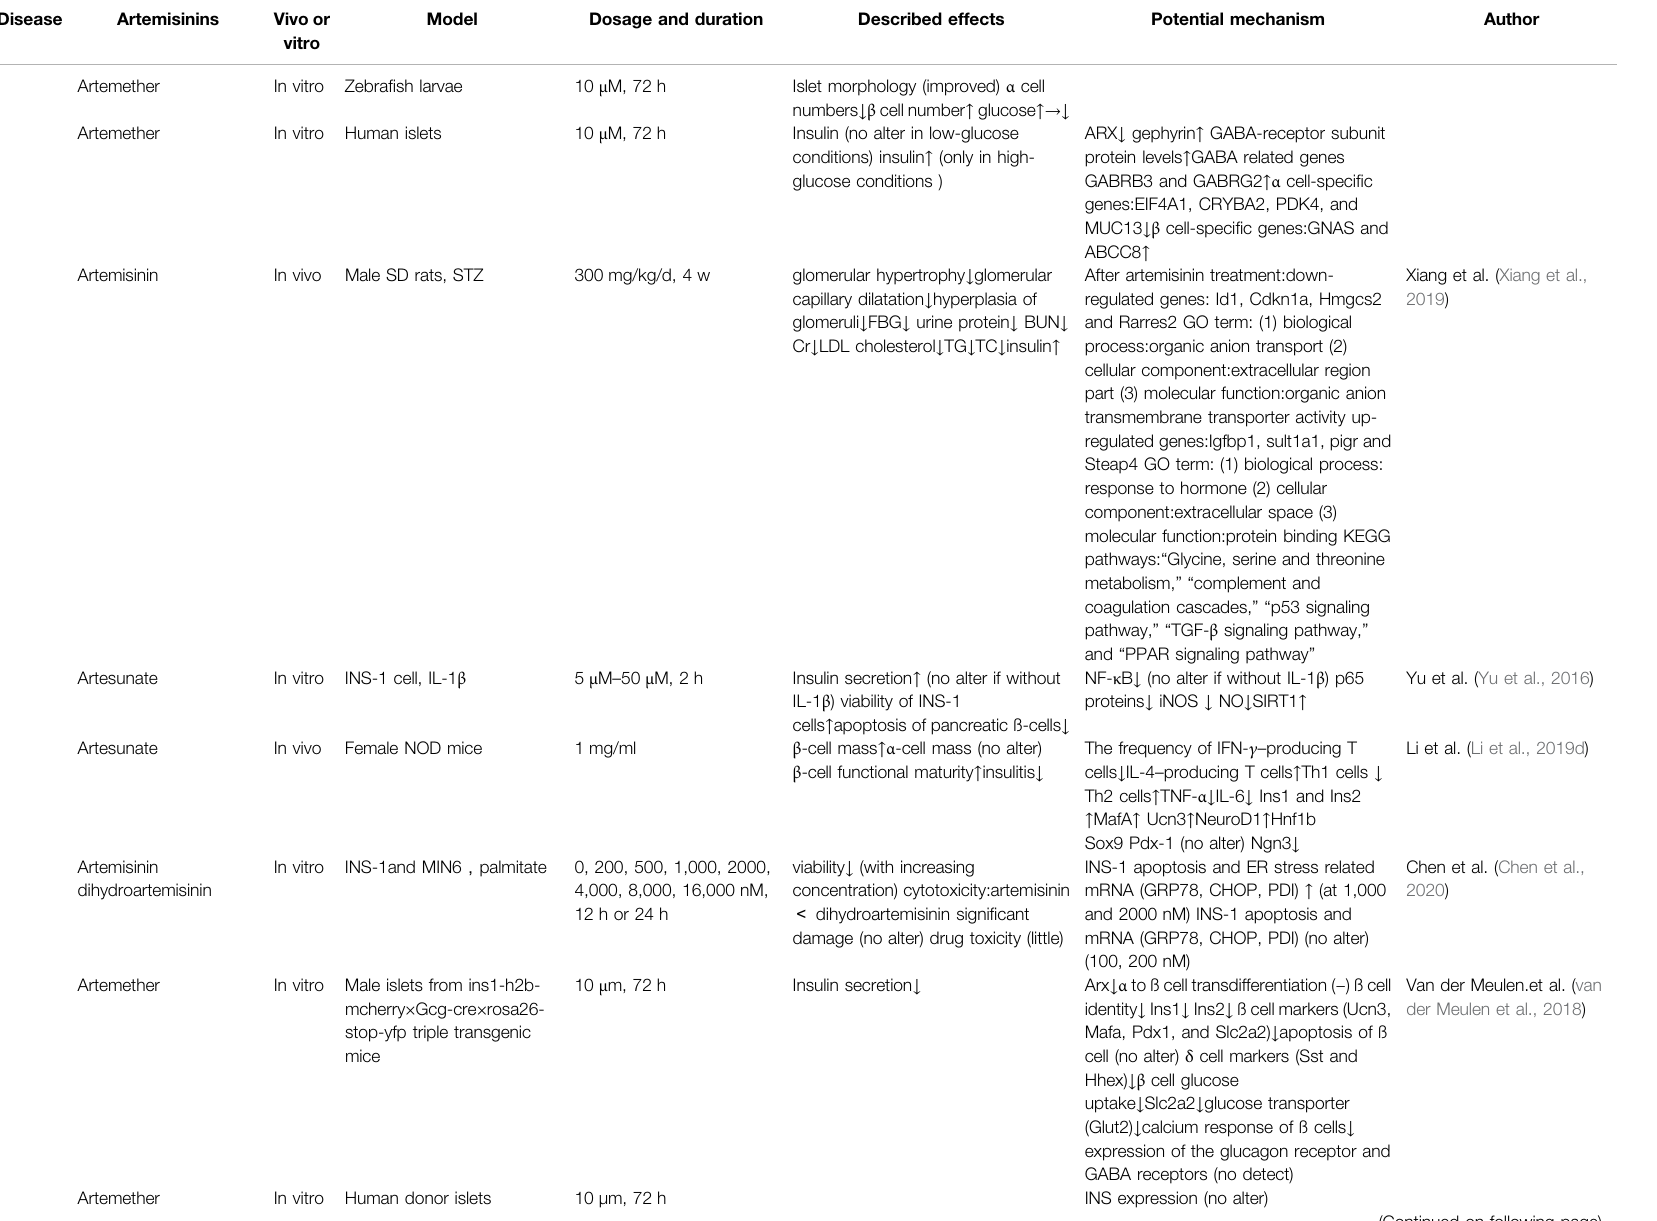
TABLE 1 | ( Continued ) Effects of artemisinin and its derivatives on